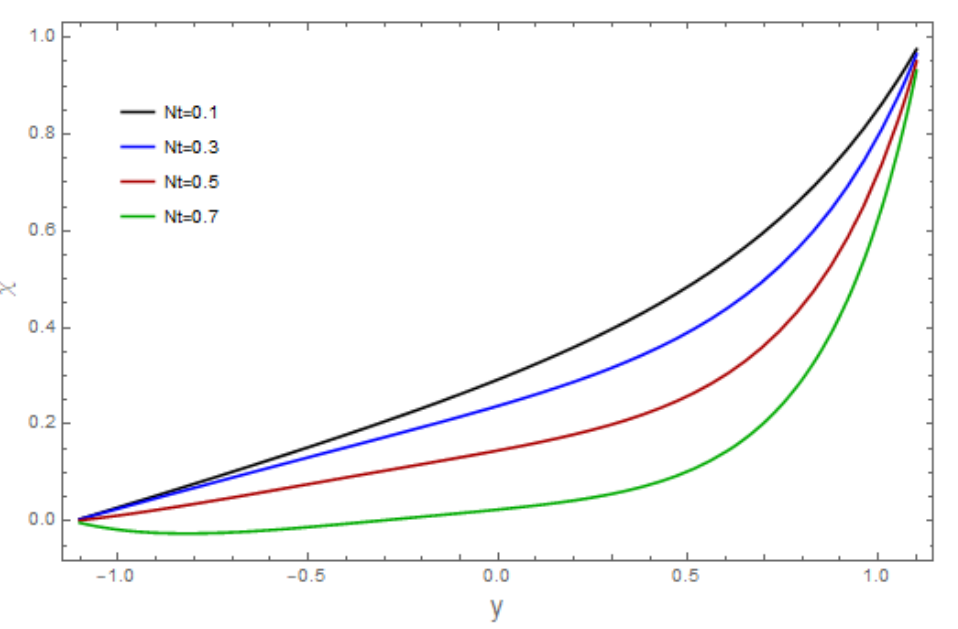
Figure 20. Effect of 𝑁𝑡 on 𝜒 .